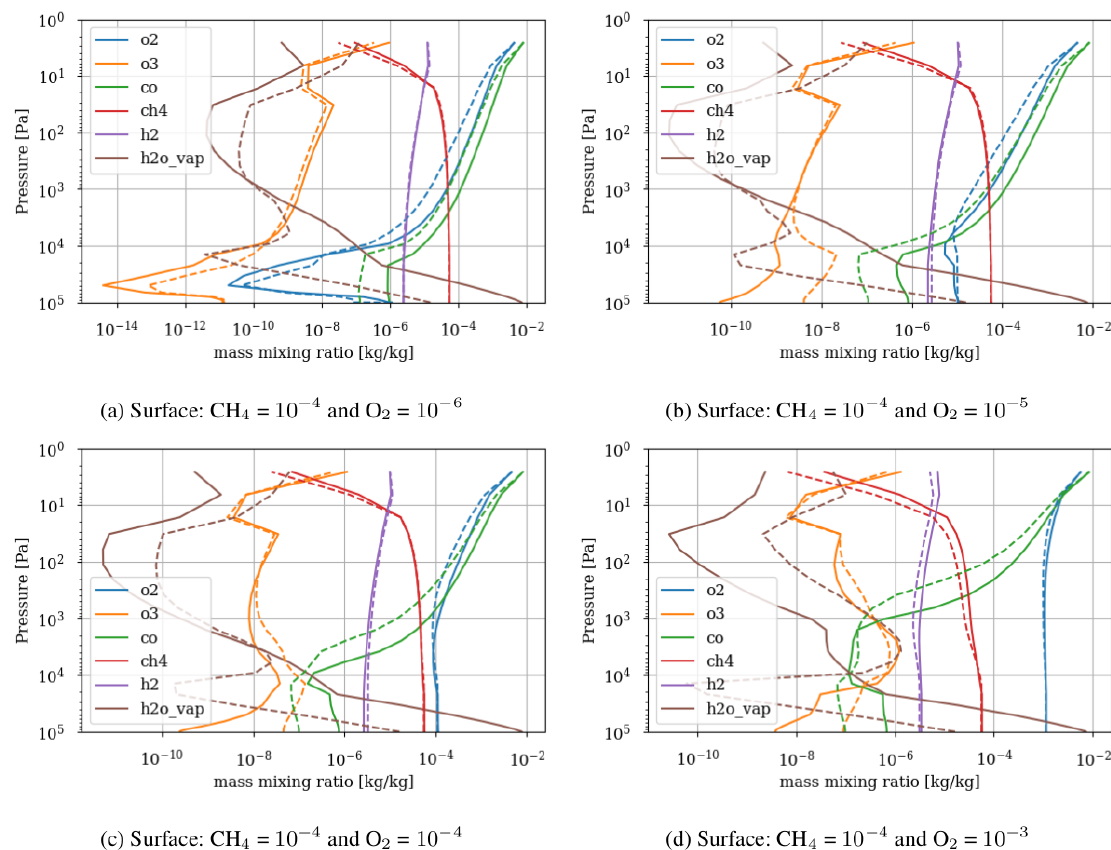
Figure 11. Species profile for a 1D model surface temperature of 280K (solid) and 220K (dashed).